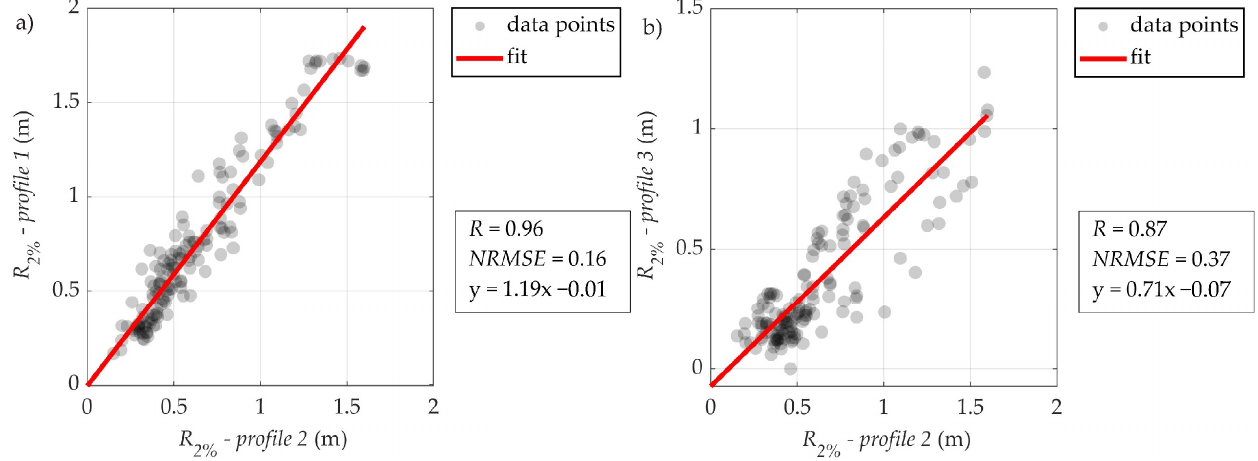
Figure 11. ( a ) Relationship between the wave runup, R 2% , measured on the centerline profile (profile 2 in Figure 1d) and westward profile (profile 1 in Figure 1d); ( b ) Relationship between the wave runup, R 2% , measured on the centerline profile (profile 2 in Figure 1d) and eastward profile (profile 3 in Figure 1d).